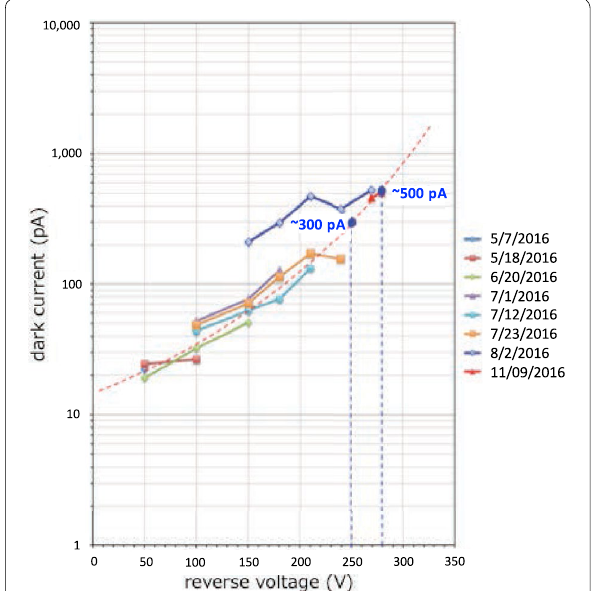
Fig. 2 Relationship between the reverse voltage applied to APD and the dark currents measured during 8 days from May 7 to November 9,